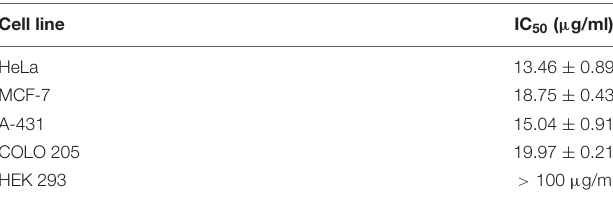
TABLE 1 | IC 50 values of AUME calculated for multiple human cell